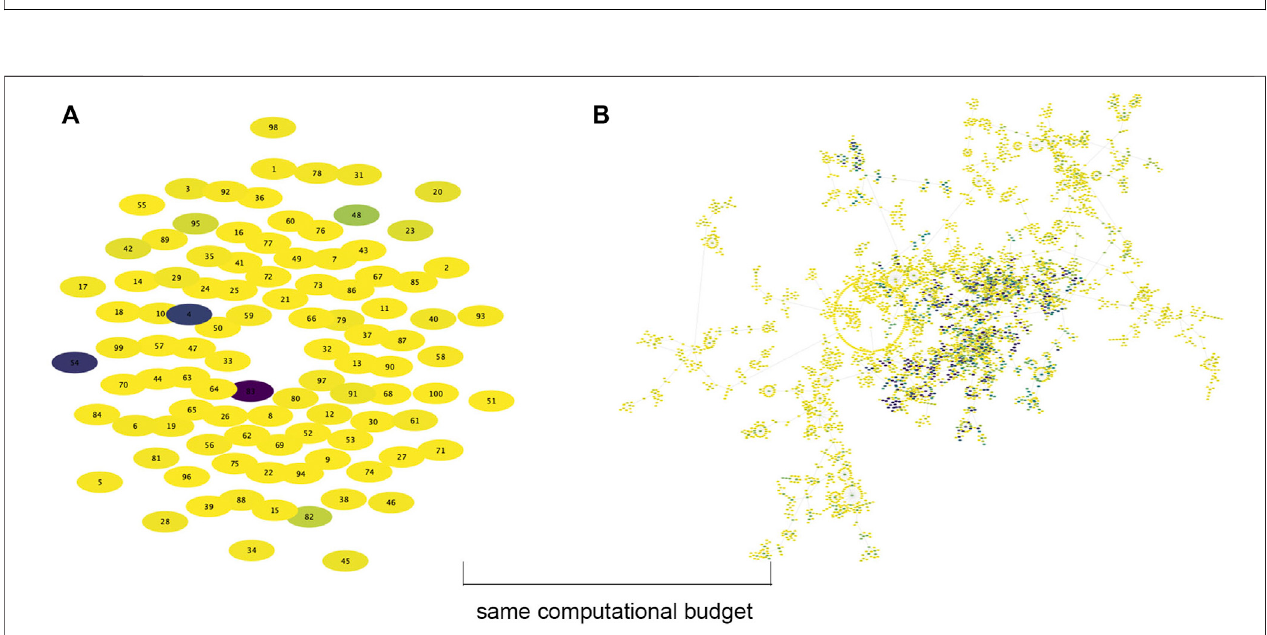
FIGURE 7 | Sub fi gure (A) shows the mean fi tness over 150,000 evaluations (averaged over 10 runs) for Evolution-Only in blue and Evolution+Learning in purple. Sub fi gure (B) shows the maximum fi tness over 150,000 evaluations (averaged over 10 runs) for Evolution-Only in blue and Evolution+Learning in purple. The shaded areas show the standard deviation. Note the different scales on the vertical axes.